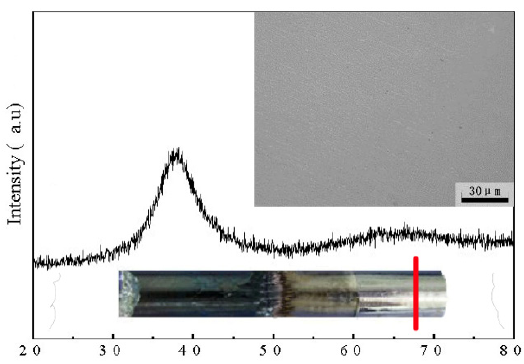
Figure 5. Temperature-Time curve of the hot point with different casting speeds.